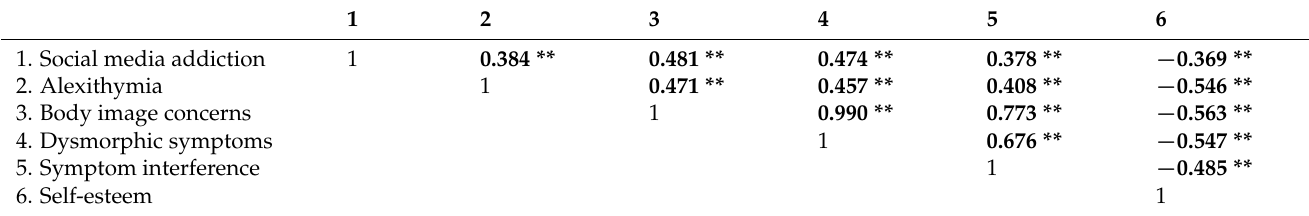
Table 2. Correlation